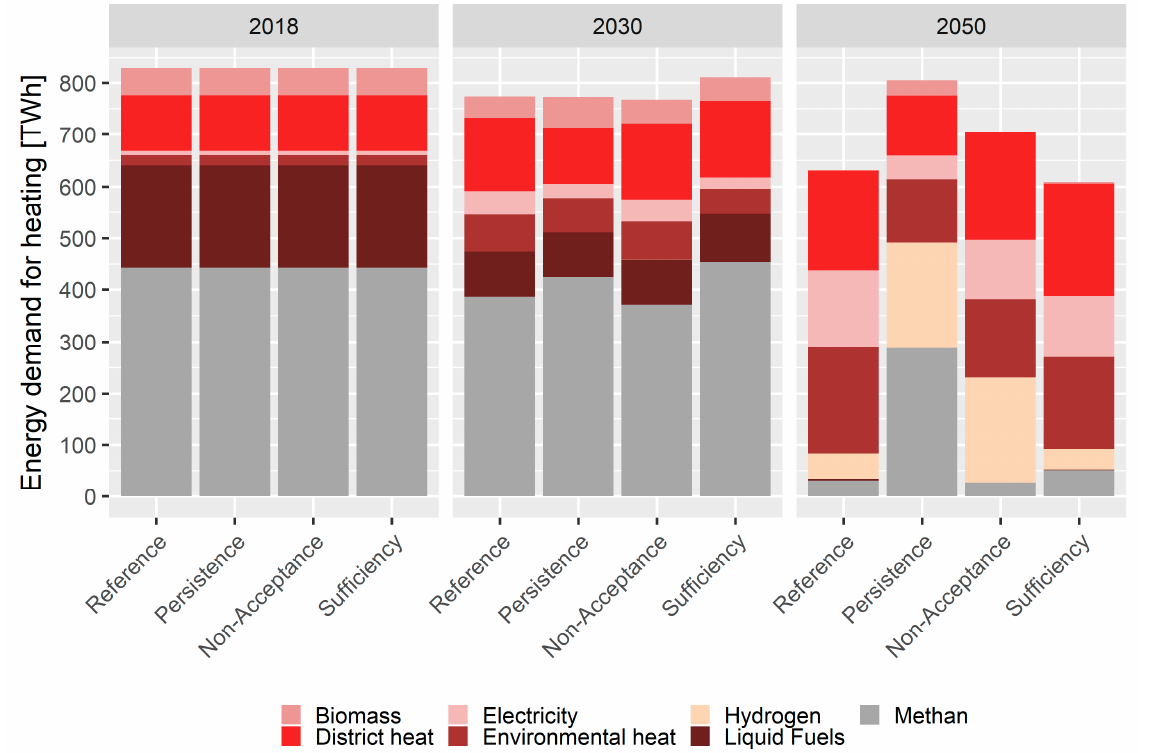
Figure 7. Present and future energy carrier mixes for building heating for the defined scenarios (results calculated with REMod).